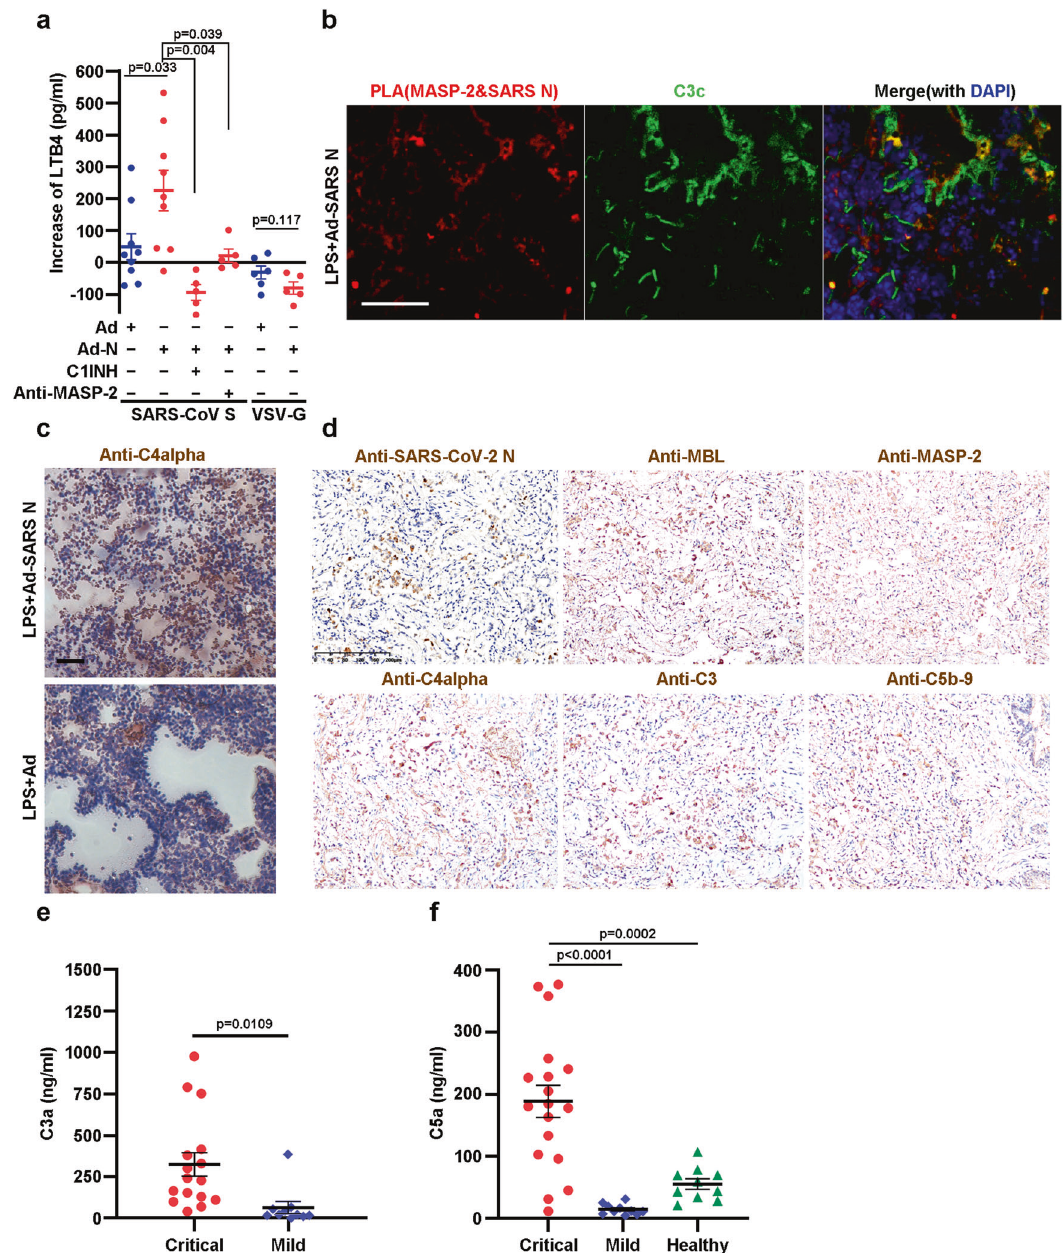
Fig. 5 N proteins potentiate pseudovirus/LPS/SARS-CoV-2-induced pneumonia with complement activation. a BALB/c mice were pre-infected with Ad-SARS N or Ad (1 × 10 9 PFU) on days 1, 2, and 3, and the SARS-CoV S protein or VSV-G pseudotyped HIV virus was injected on the 4th day via the tail vein. Sera were collected at 0 and 6 h post-pseudovirus injection, serum LTB4 was detected, and an increase in the serum LTB4 levels was observed. b Mice were infected with 1 × 10 8 PFU Ad-SARS N, and LPS was injected on the 7th day post-infection. The mice were sacri fi ced 6 h after the LPS challenge. SARS-CoV N and MASP-2 complex formation in frozen lung sections was measured by in situ PLA (red signals). Deposited C3 fragments were stained with a FITC-labeled anti-C3c antibody (green). Scale bar, 50 μ m. c Frozen lung sections from the indicated mice in ( b ) were stained with an anti-C4alpha antibody. Data in a – c are representative of two independent experiments. d Paraformaldehyde- fi xed lung tissues from COVID-19 postmortem autopsies were used for paraf fi n tissue sections and IHC staining with the indicated antibodies. Microphotography was carried out by an Olympus BX52 microscope under a 10× objective. Scale bar, 200 μ m. Serum C3a ( e ) and C5a ( f ) levels in critical COVID-19 patients were analyzed by ELISA. The data are presented as the mean ± SEM. The statistical analysis was performed using an unpaired two-tailed Student ’ s t -test (Calbiochem), recombinant MBL (Calbiochem), mannan (Sigma), immunoblot analysis with puri fi ed prokaryotically expressed and SARS-CoV N protein with/without C1INH (Calbiochem), anti- MASP-2 as a standard control. MASP-2 (Santa Cruz), and anti-SARS-CoV N antibody (Sino Biological) at concentrations of 50 nM, 30 nM, 15 ng/ml, 10 nM, MASP-2 autoactivation and C4 cleavage assay 40 μ g/ml, 2.4 μ g/ml and 12 μ g/ml, respectively. The cleavage was Puri fi ed MASP-2 (8 nM) was incubated at 37 °C for 3 h in 20 mM followed by SDS-PAGE under reducing conditions, and the Tris-HCl (pH 7.4), 150 mM NaCl, and 2 mM CaCl 2 with puri fi ed C4 Signal Transduction and Targeted Therapy (2022)